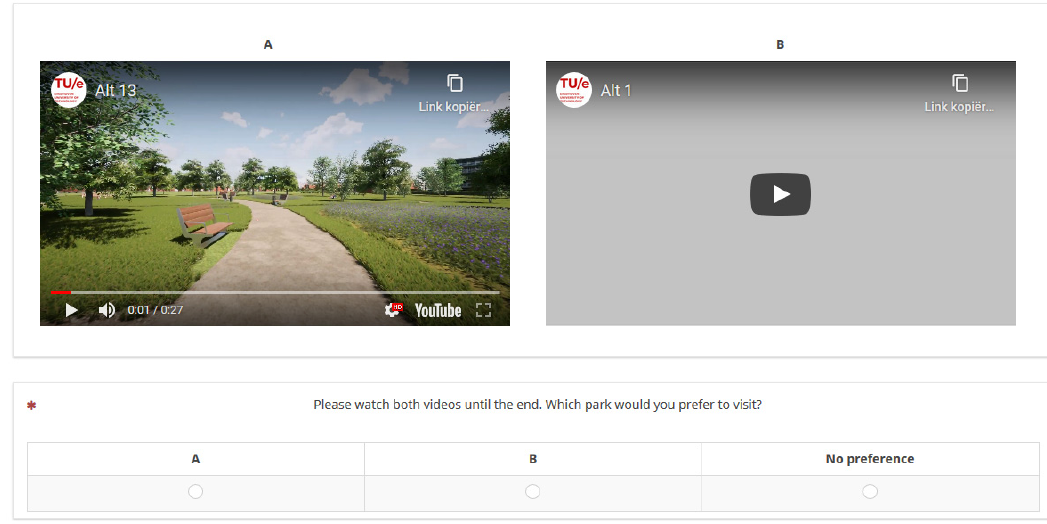
Figure 2. Screenshot of a choice task.